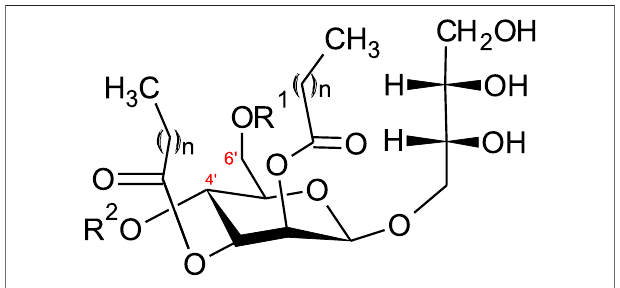
FIGURE 2 | Structure of mannosylerythritol lipids ( n = 6 – 10) (Konishi et al., 2007a; Yu et al., 2015). MEL-A – R 1 = CH 3 CO, R 2 = CH 3 CO. MEL-B – R